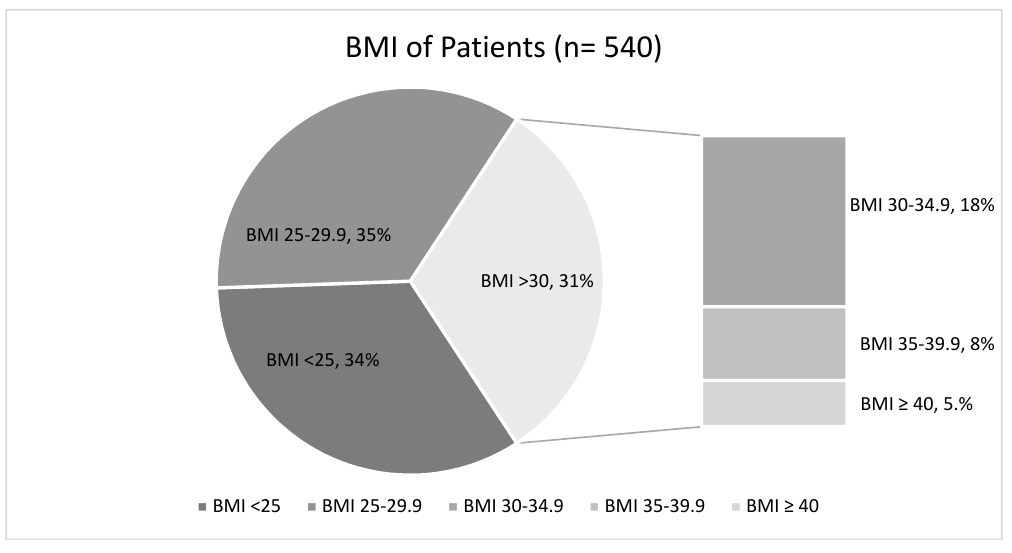
Figure 2. Body mass index (BMI) distribution of the patients ( n = 540). Table 1. Demographic characteristic and comorbidities of study population.